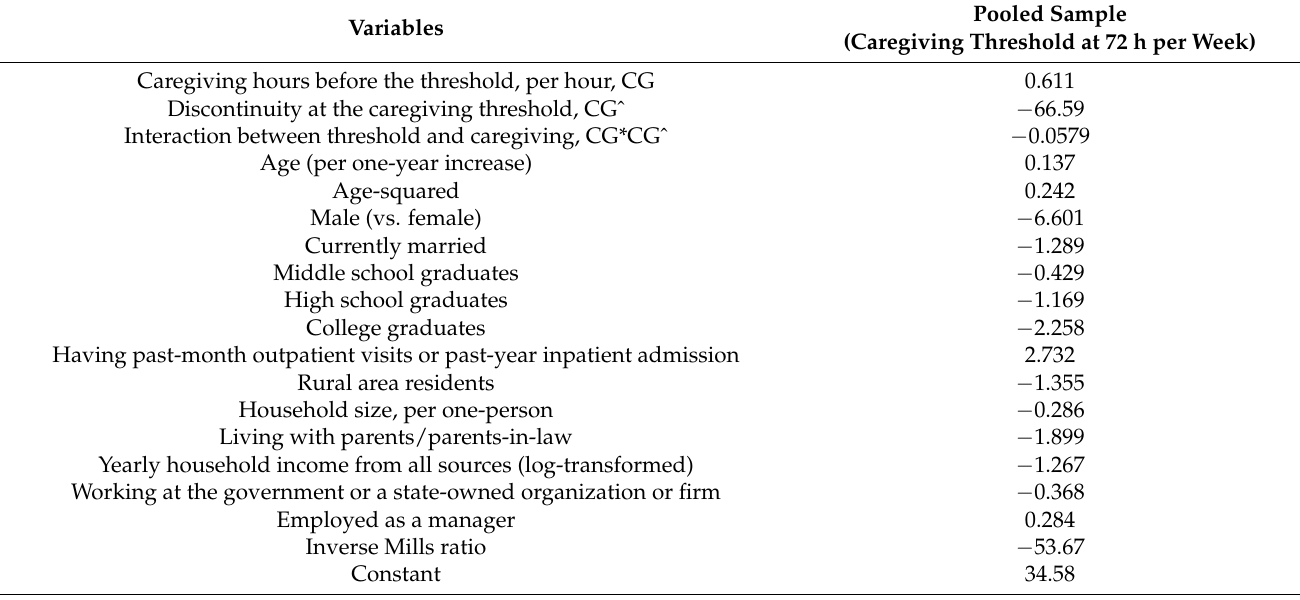
Table A4. Results of an instrumental variables analysis conducted on the pooled